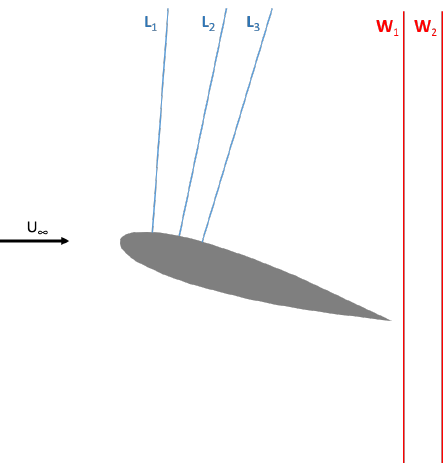
Figure 5. Location of measurement lines used to obtain the power spectra of flow